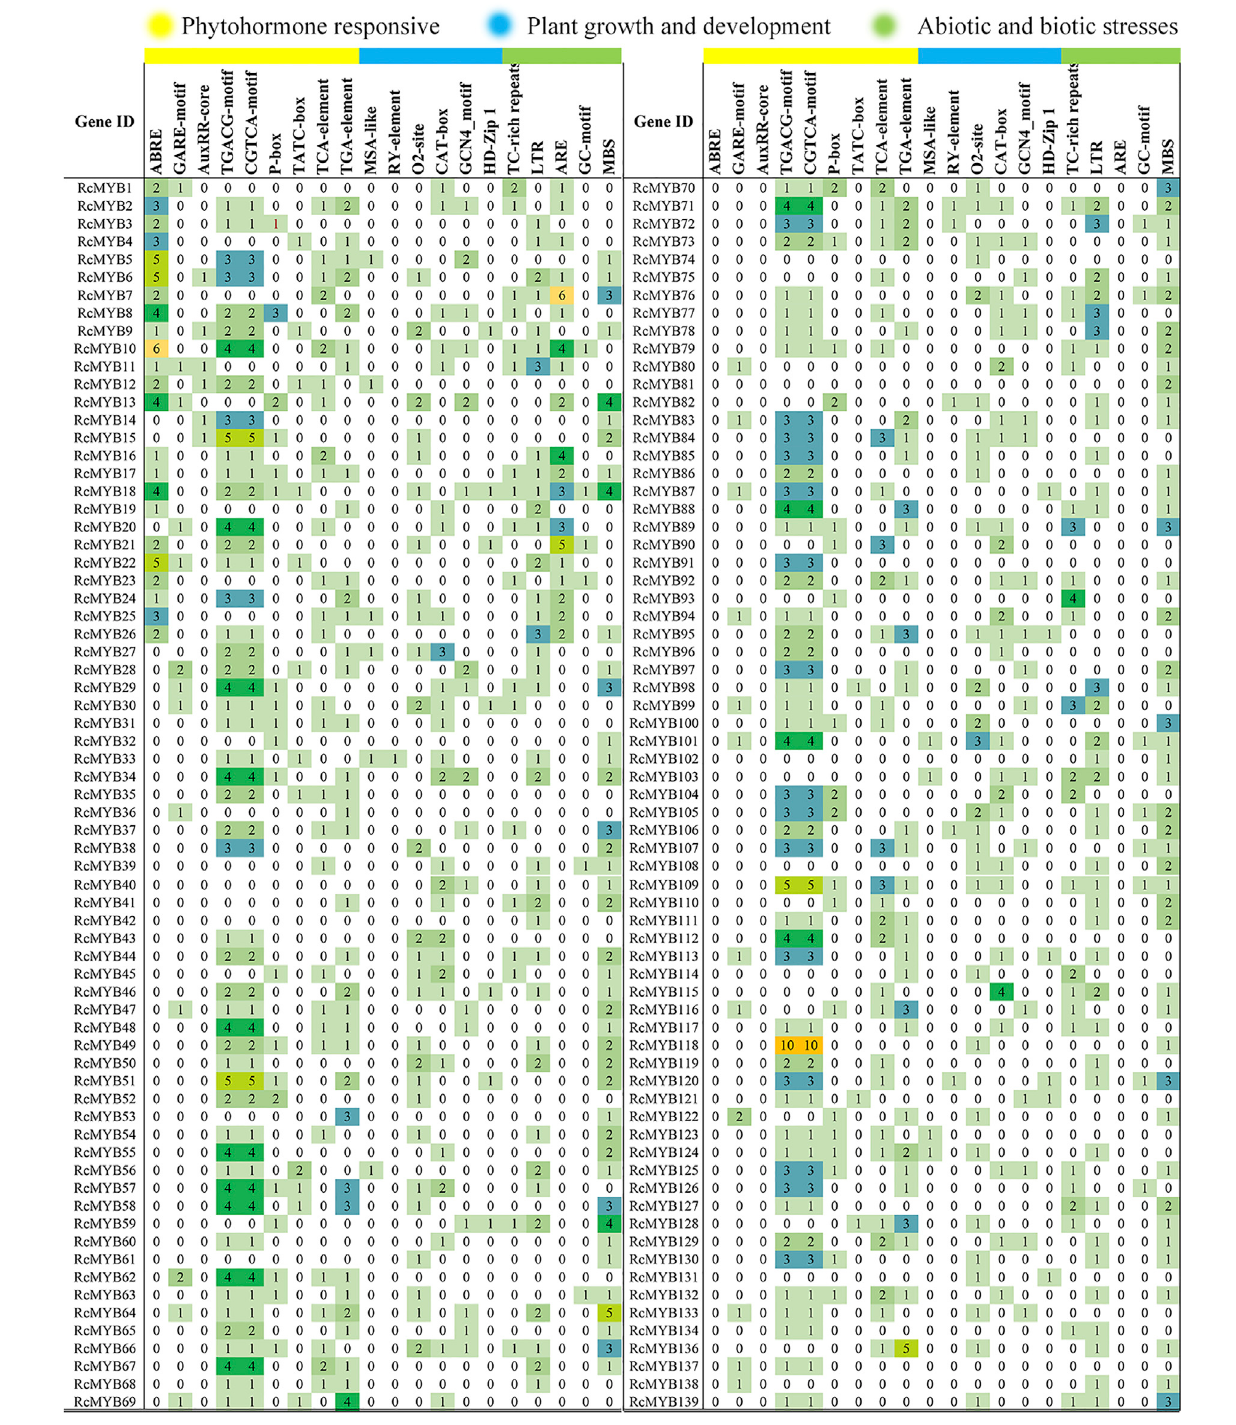
FIGURE 4 | Number of each cis-acting element in the RcMYB genes in the promoter region. The detailed cis-element is listed in Supplementary Table S4 .